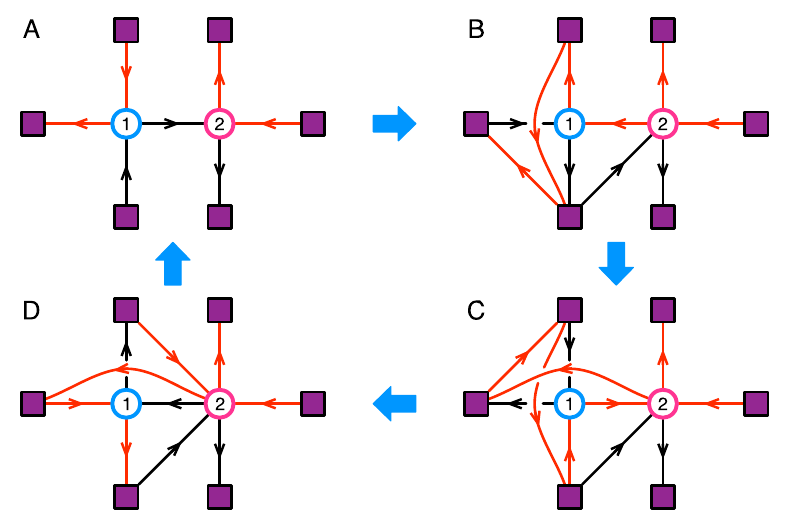
Figure 11 . Quadrality loop obtained by acting repeatedly with quadrality on the same gauge node, node 1, of a 2-gauge/6-(cid:13)avor